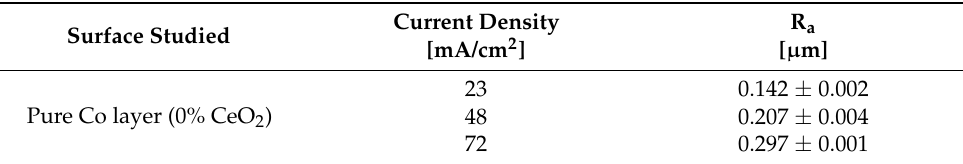
Table 3. Average value of roughness measurements (R a ) for layers obtained at different current